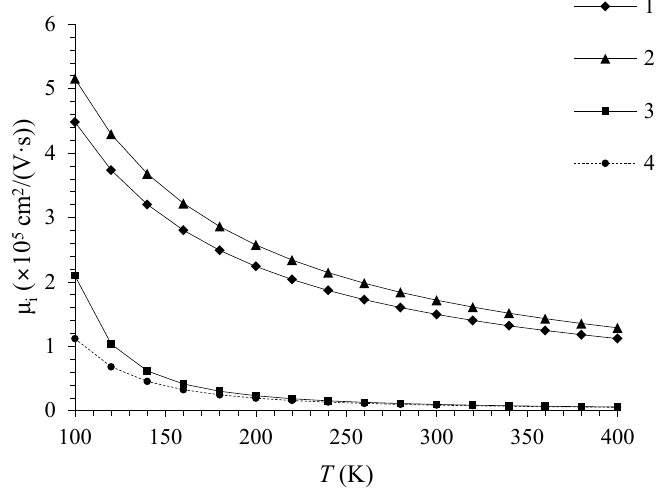
Fig. 1. Temperature dependence of the two-dimensional electron gas for n = 1×10 12 cm -2 : 1 – acoustic deformation potential scattering, 2 – polar acoustic phonon scattering, 3 – polar optical phonon scattering, 4 – combined mobility.